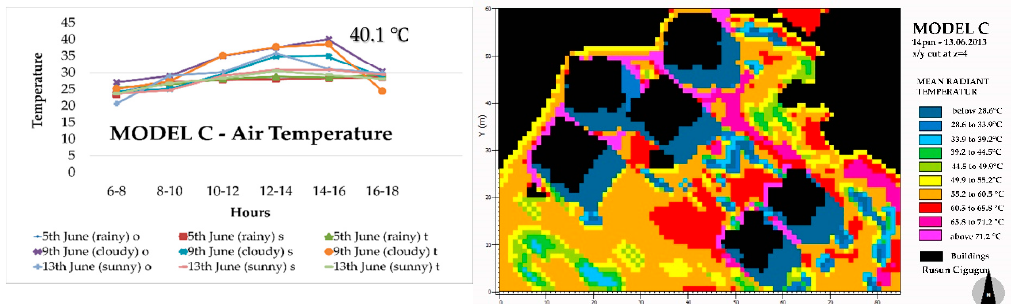
Figure 5. Model D—Square Plot Microclimate.